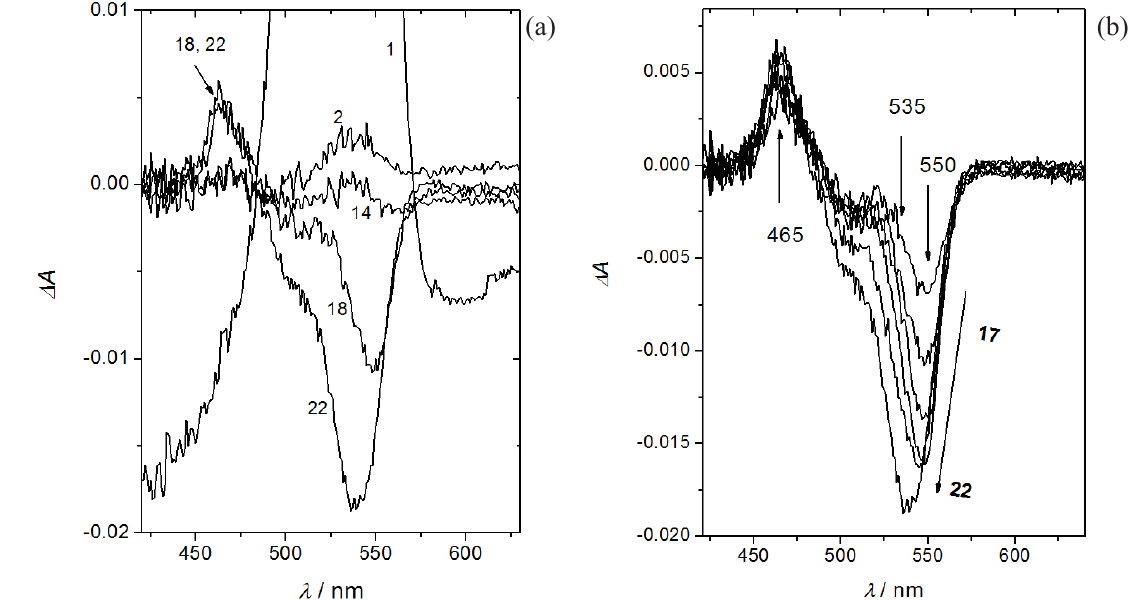
Figure 1. Selected time-difference spectra related to the reaction of rhodamine 6G and montmorillonite in colloid at 20ºC. a. The numbers of